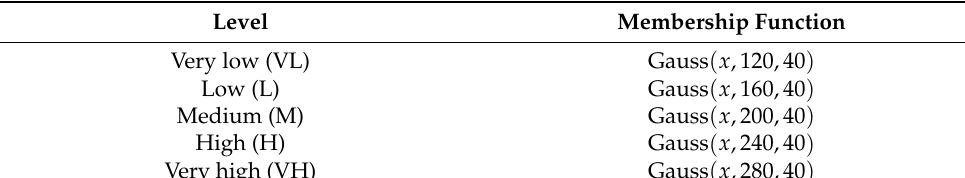
Table 4. Membership functions for the fuzzification of students’ attainments on the INVALSI test.